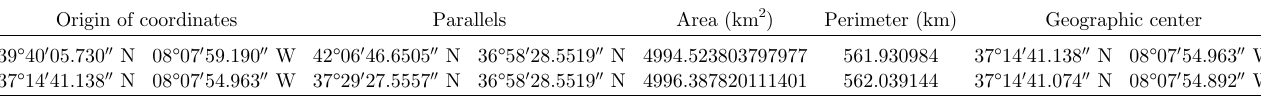
Table 6. Analysis by using OAM Algarve (1st line) and NAM Algarve (2nd line) with LCC. Origin of coordinates Parallels Area (km 2 ) Perimeter (km) Geographic center